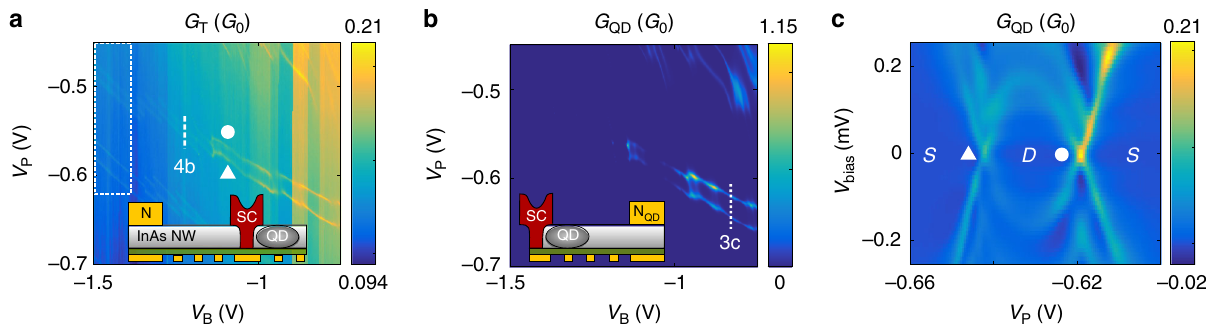
Fig. 3 Direct characterization of the Shiba state. Differential conductance of the tunnel probe (panel a ) and the quantum dot (panel b ) in a larger gate , the quantum dot also voltage range without magnetic fi eld. The white dashed rectangle marks the region already presented in Fig. 2a. For more positive V B couples to the right normal lead, N , while the conductance enhancement persists in G . The coincidence of the conductance lines on panels a and b QD T indicates that the tunnel probe measures the level structure of the quantum dot non-locally. c Finite bias characterization of the quantum dot with open barrier at V 0 : 83 V, along the white dotted line in panel b . The eye-shaped crossing is the signature of the Shiba state, S and D denotes the ground B ¼ (cid:3) state Figure 4c and d compare the experimental and NRG results as a function of magnetic fi eld. In panel c the spectral weight for the experimental data is evaluated along the two dashed lines in panel independent conductance background was subtracted b. The V P ð V Þ , and the excess tunnel conductance Δ G ð V Þ was from G T P T P integrated for the enhancement peaks (marked by circle and triangle) to get the total excess current/spectral weight induced by